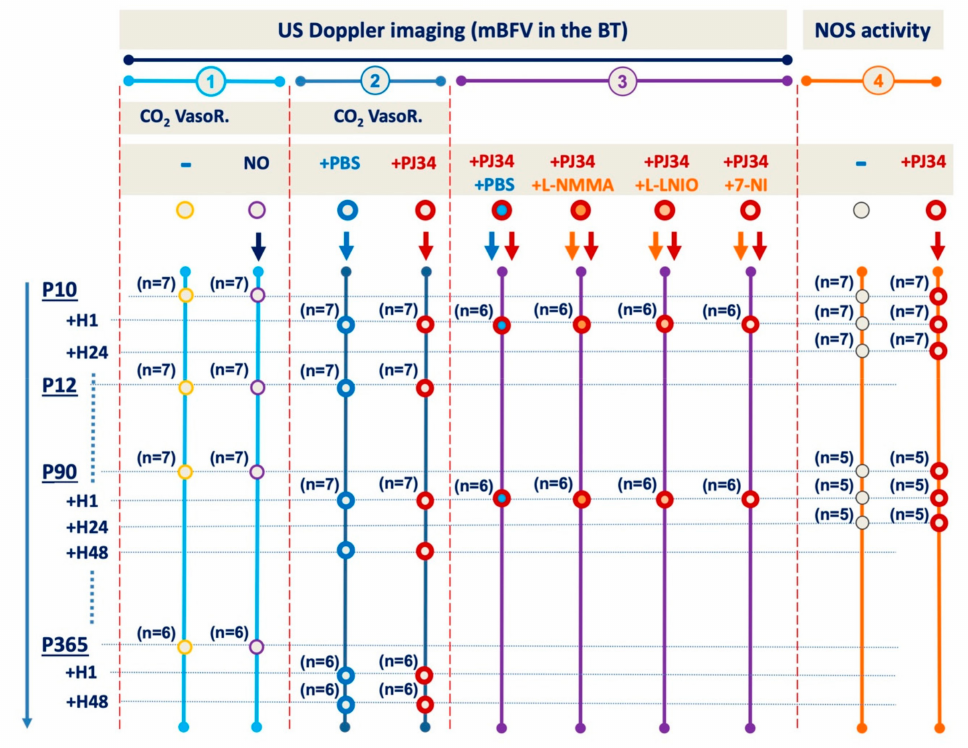
Figure 6. Outline of the experimental procedure in C57Bl / 6j mice subjected to cerebral vasoreactivity in absence and / or presence of PJ34 and in presence of NOS